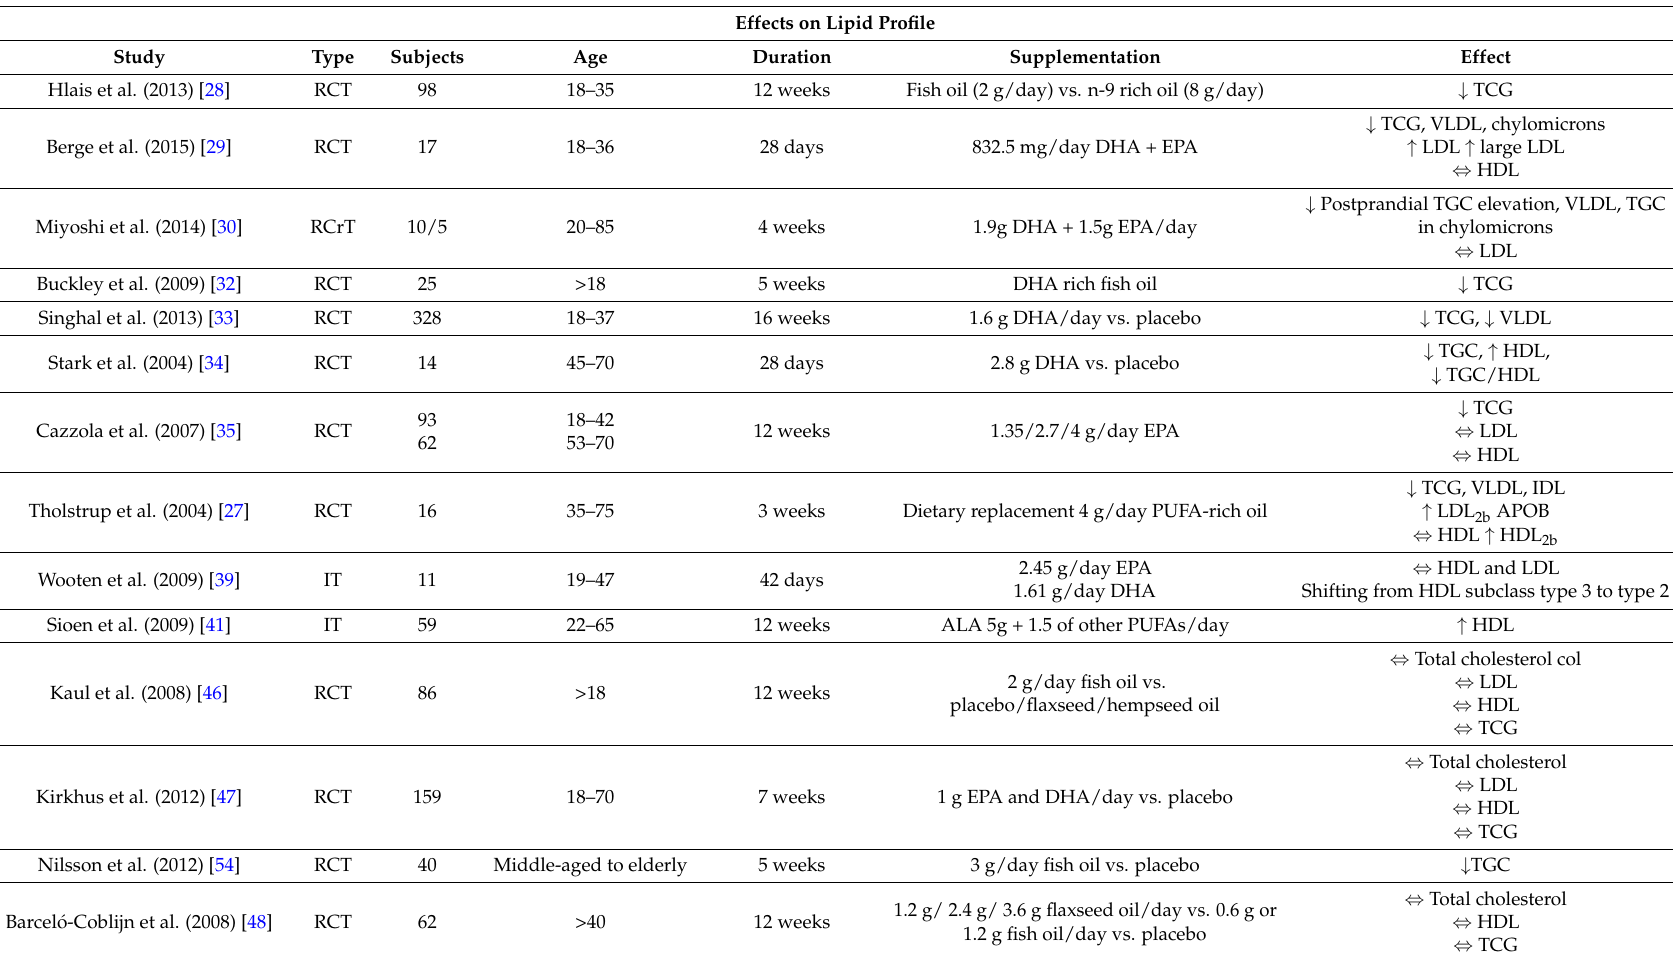
Table 1. Synopsis showing the main results of the studies discussed, sorted by